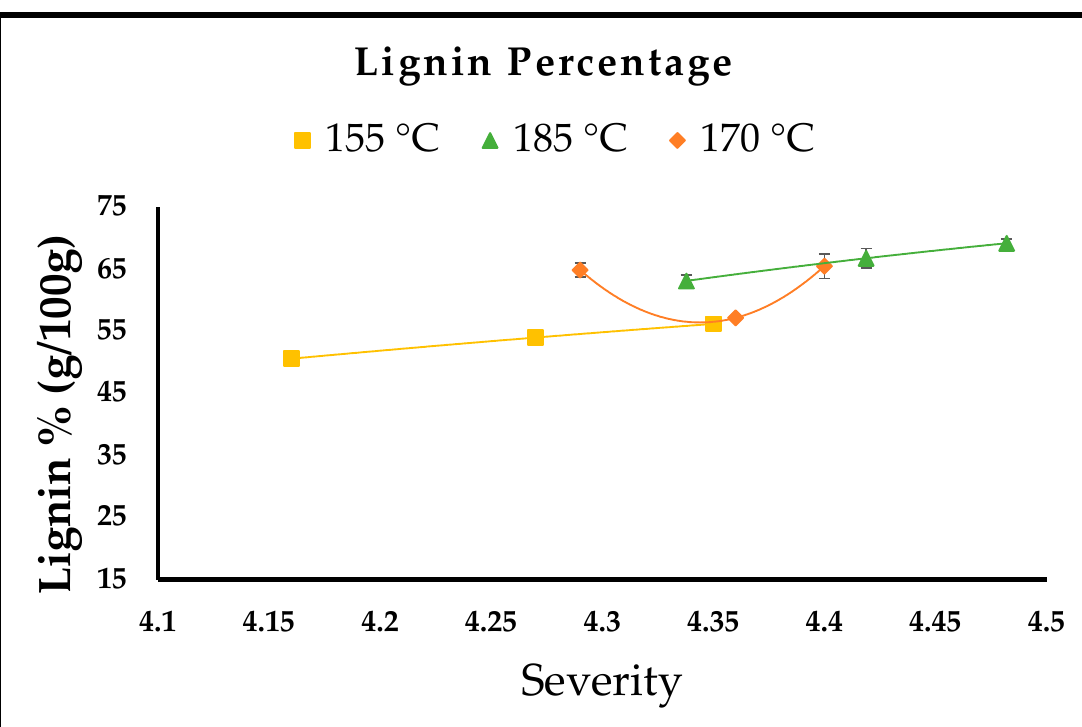
Figure 3. Lignin percentage (g/100 g).